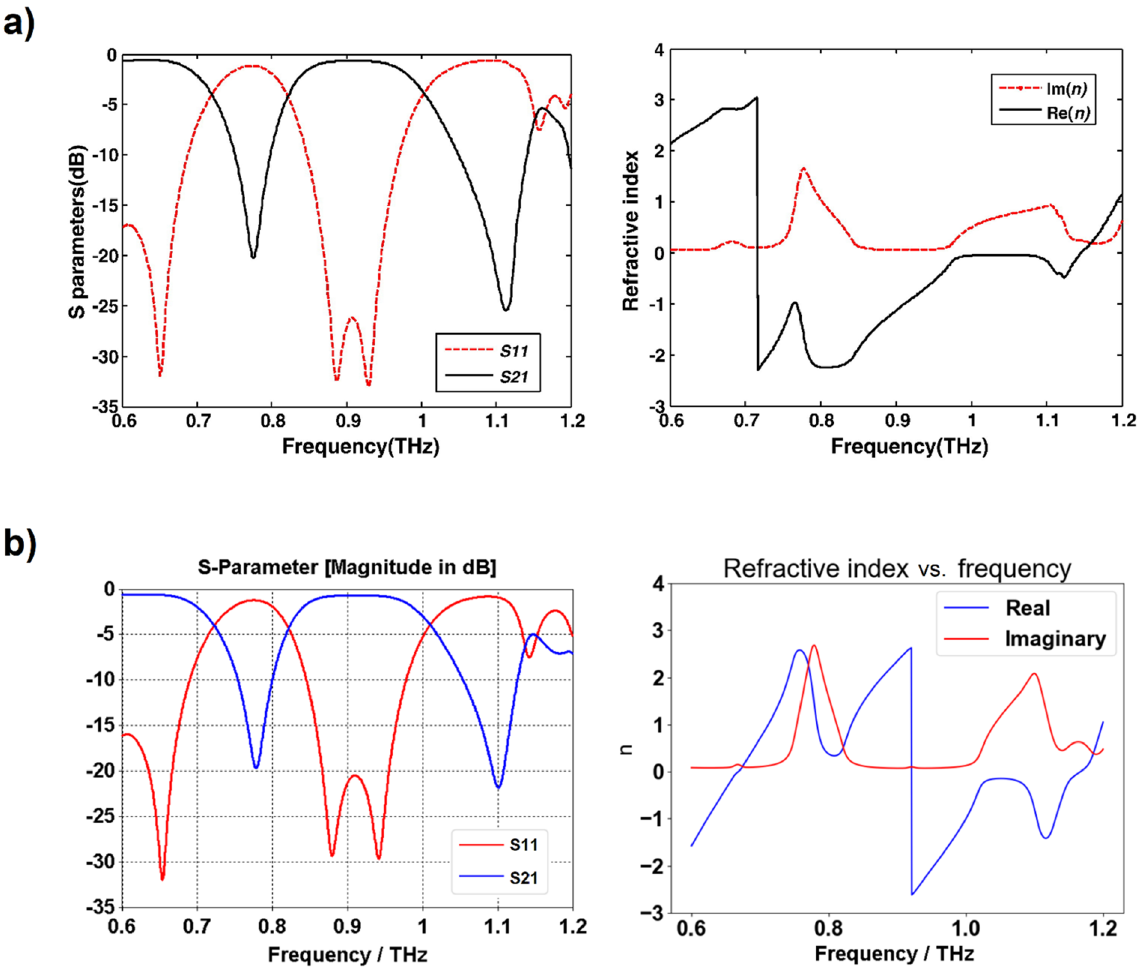
Figure 6. Comparison between Du et al.’s three-dimensional fishnet metamaterial simulation results 16 in ( a ) ([Reprinted/Adapted] with permission from 16 © Elsevier) and our own results in ( b ).